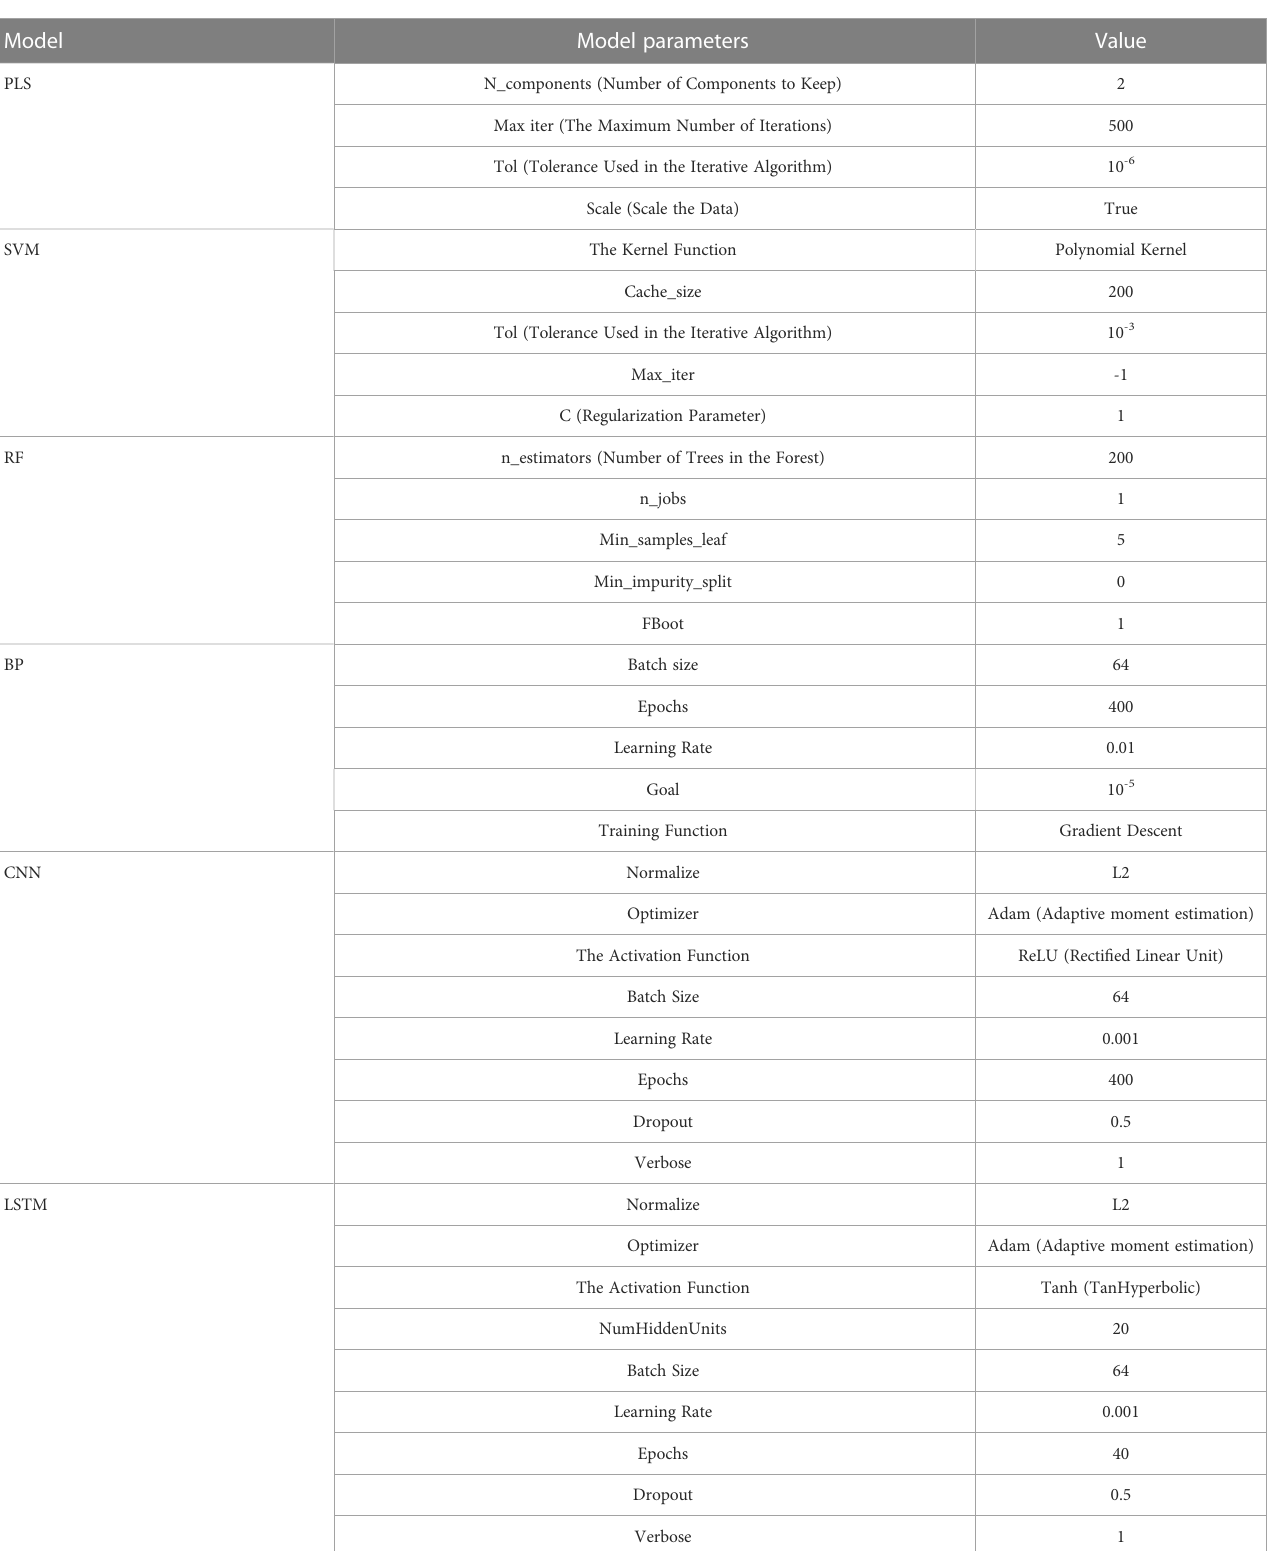
TABLE 3 Main parameters of the PLS, SVM, RF, BP, CNN, and LSTM models.